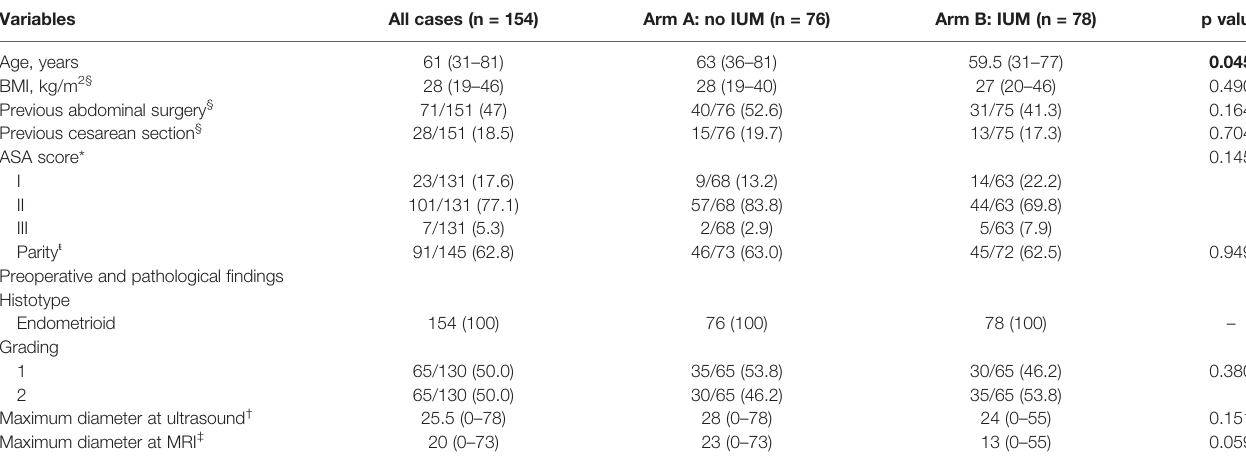
TABLE 1 | Patient/Disease baseline